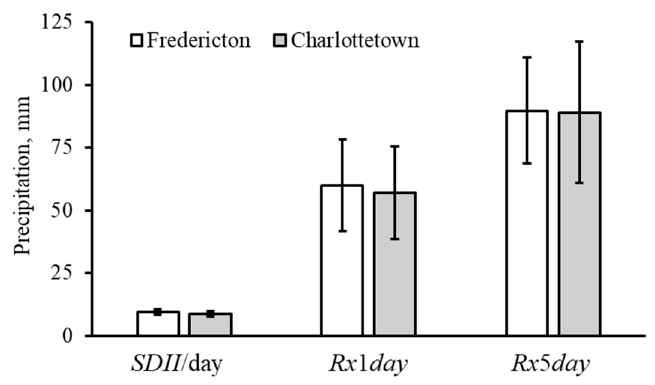
Figure 3. The mean values of precipitation depth (mm) for the simple daily intensity index (mm/day), the maximum 1-day precipitation, and the maximum 5-day precipitation with their overlapping standard deviation bars reflecting no statistically significant difference between the annual means of the mentioned indices of Fredericton (open columns) and Charlottetown (shaded columns).